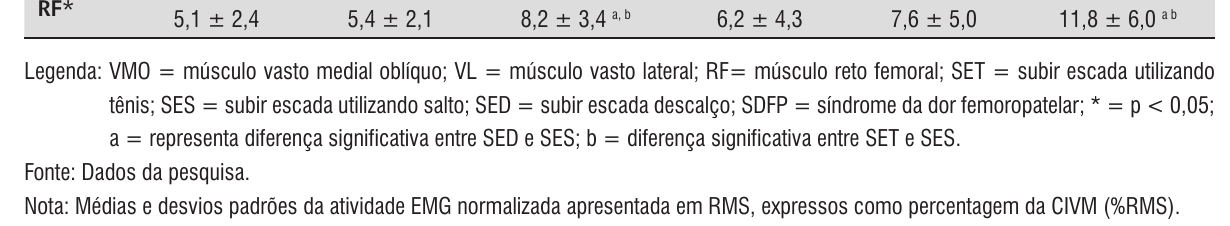
Legenda: VMO = músculo vasto medial oblíquo; VL = músculo vasto lateral; RF= músculo reto femoral; SET = subir escada utilizando tênis; SES = subir escada utilizando salto; SED = subir escada descalço; SDFP = síndrome da dor femoropatelar; * = p < 0,05; a = representa diferença significativa entre SED e SES; b = diferença significativa entre SET e SES. Fonte: Dados da